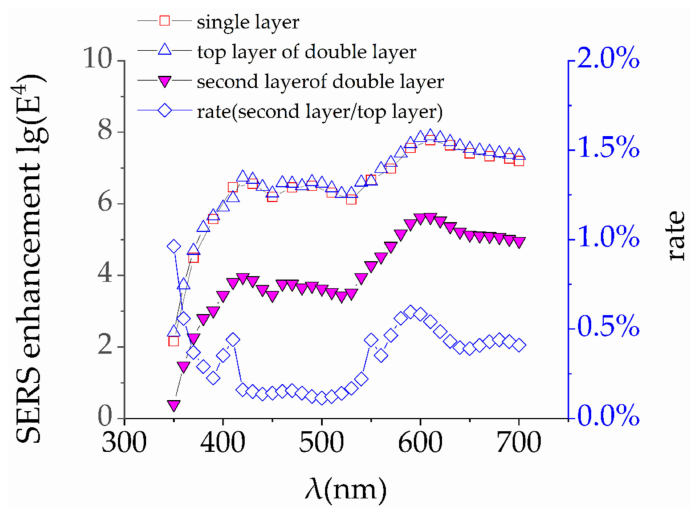
Figure 12. We compare the E 4 obtained by the top layer of the double layer and the single layer, and find that two curves are almost identical. The second layer only achieves an enhancement of 4 to 6 orders of magnitude. Compared with the top layer, the enhancement of the second layer is only about 0.1 to